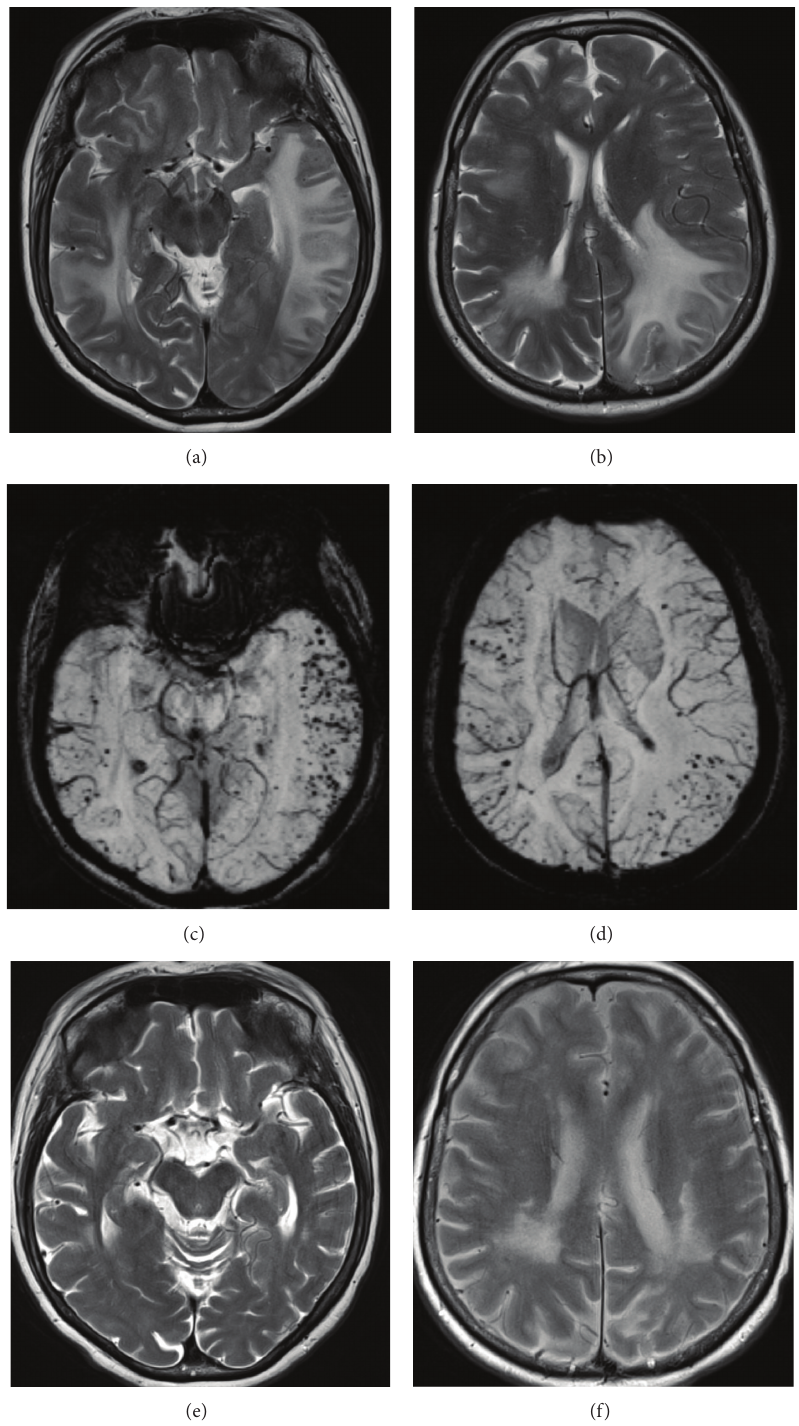
Figure 2: (a and b) T2 TSE images showing multifocal areas of white matter T2 hyperintensity. (c and d) Susceptibility weighted images showing multiple foci of microhemorrhage. (e and f) Follow-up T2 TSE images at 6 months showing significant interval improvement of white matter